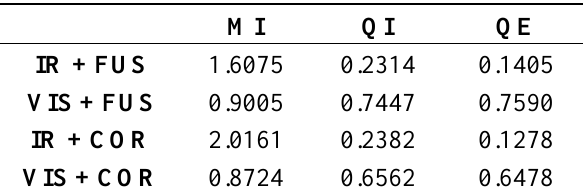
Table 6. Quantitative analysis of IR and VIS image fusion and correction (1300 LST 25 July